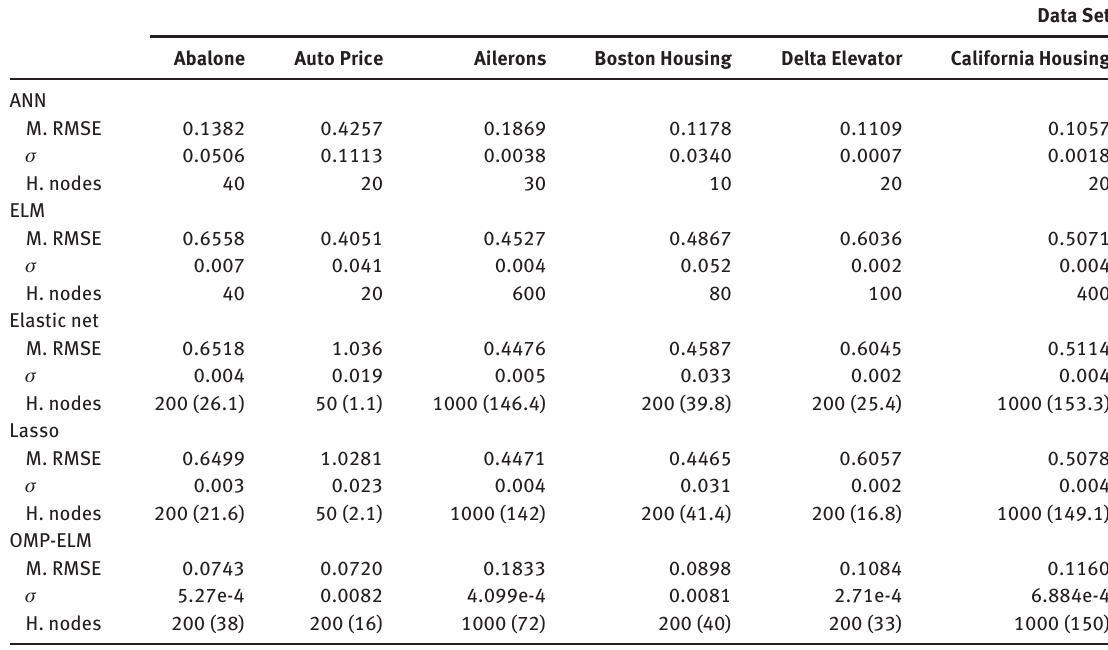
Table 4. Comparison of the Proposed Method with ANN, Standard ELM, Elastic Net, and